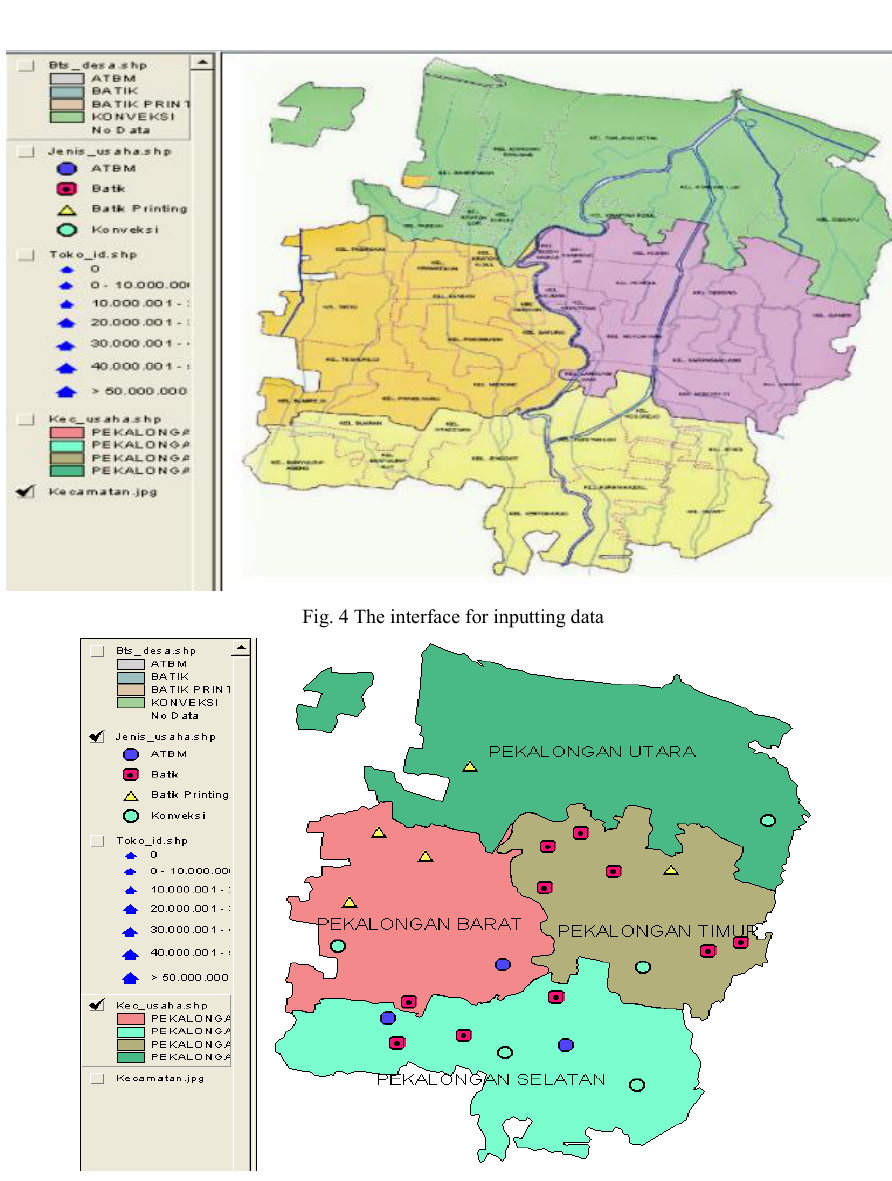
Fig. 5 Interface for information about center of batik